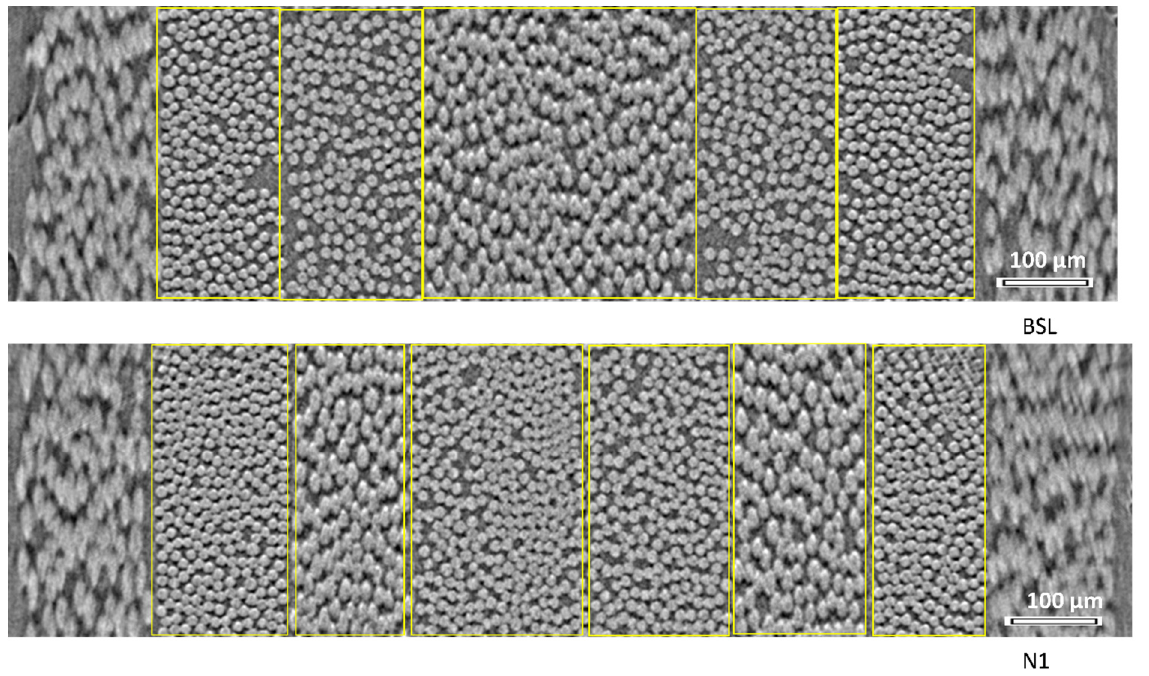
Figure 3. The scheme of measurement of plies’ thicknesses (measurement for N2 is similar to N1 and not illustrated).